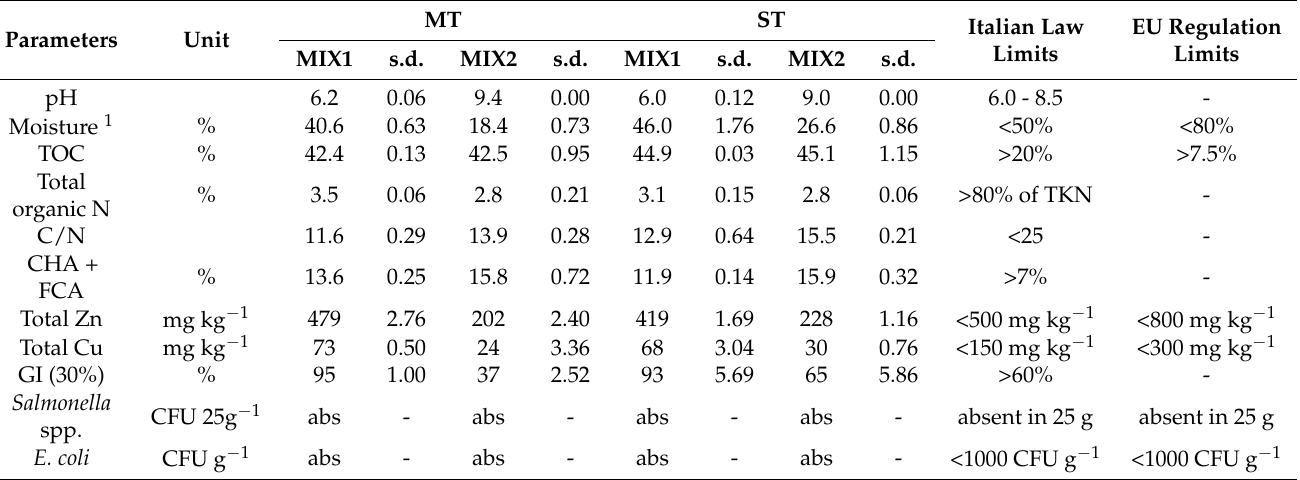
Table 3. Physicochemical and biological characteristics of the final composts, with the respective Italian law (D.Lgs. 75/2010) and European Regulation (2019/1009)